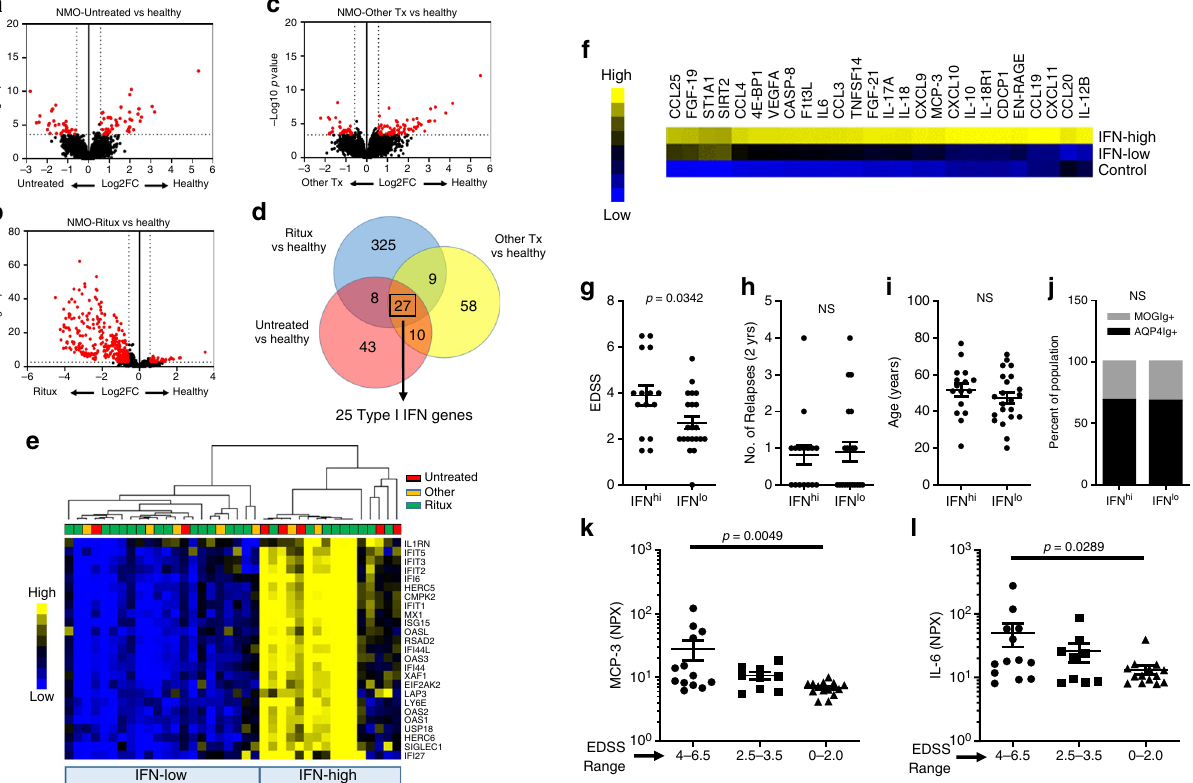
Fig. 1 NMOSD patients stratify into two groups based on IFN-I gene expression. RNA pro fi les of a untreated patients (NMO-untreated; n = 7), b Rituximab-treated patients (NMO-Ritux; n = 24) and c patients on other therapies (NMO-Other Tx; n = 7) were compared with healthy volunteers ( n = 18). d Venn diagram of differentially expressed genes of the NMO-Untreated vs healthy, NMO-Ritux vs healthy, and NMO-Other Tx vs healthy. e Heatmap depicts relative levels of IFN-I genes in NMOSD patients (Red = NMO-Untreated, Yellow = NMO-Other Tx, Green = NMO-Ritux). Patients were strati fi ed into two groups, IFN-low and IFN-high, based on IFN-I gene expression. Yellow represents relative high expression and blue represents relative low expression. f Heatmap depicts the differentially abundant serum proteins in IFN-high NMOSD ( N = 16), IFN-low NMOSD ( n = 22), and healthy controls ( n = 18). Yellow represents relative high serum levels; blue represents relative low serum levels. Comparison of g disability (EDSS), h number of relapses 2 years prior to sample collection, i age, and j autoantibody status of IFN-high and IFN-low NMOSD patients. Two-tailed Student ’ s t tests and Chi-square tests were used to determine statistical signi fi cance. k MCP-3 and l IL-6 levels in NMOSD patients of different EDSS range (EDSS 4 – 6.5: n = 15, EDSS 2.5 – 3.5: n = 9, EDSS 0 – 2: n = 16). P values were determined using two-tailed Kruskal – Wallis tests with multiple comparisons corrected by the Dunn ’ s method. Bar graphs represent the mean and error bars are the S.E.M. Source data are provided as a Source Data fi le.